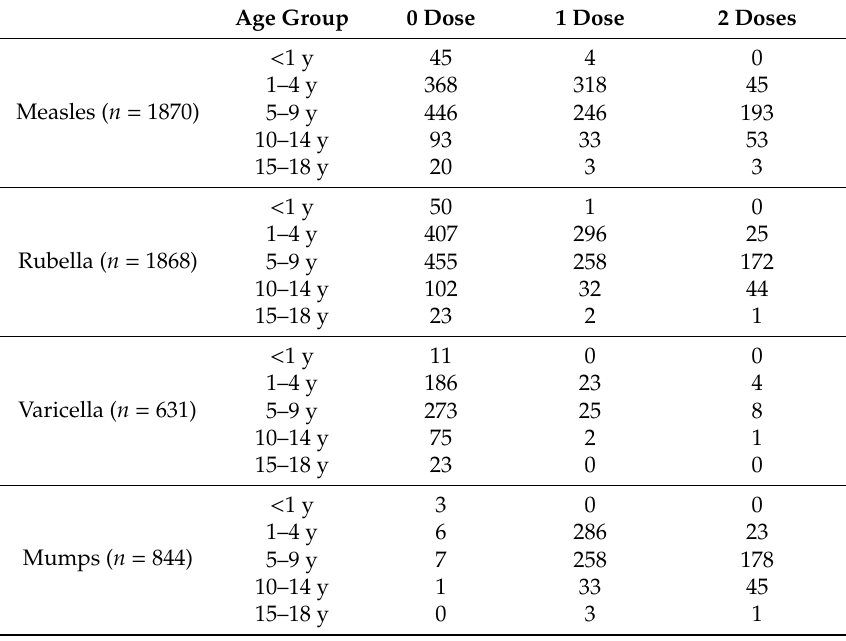
Table 6. Number of doses documented for IAC by age